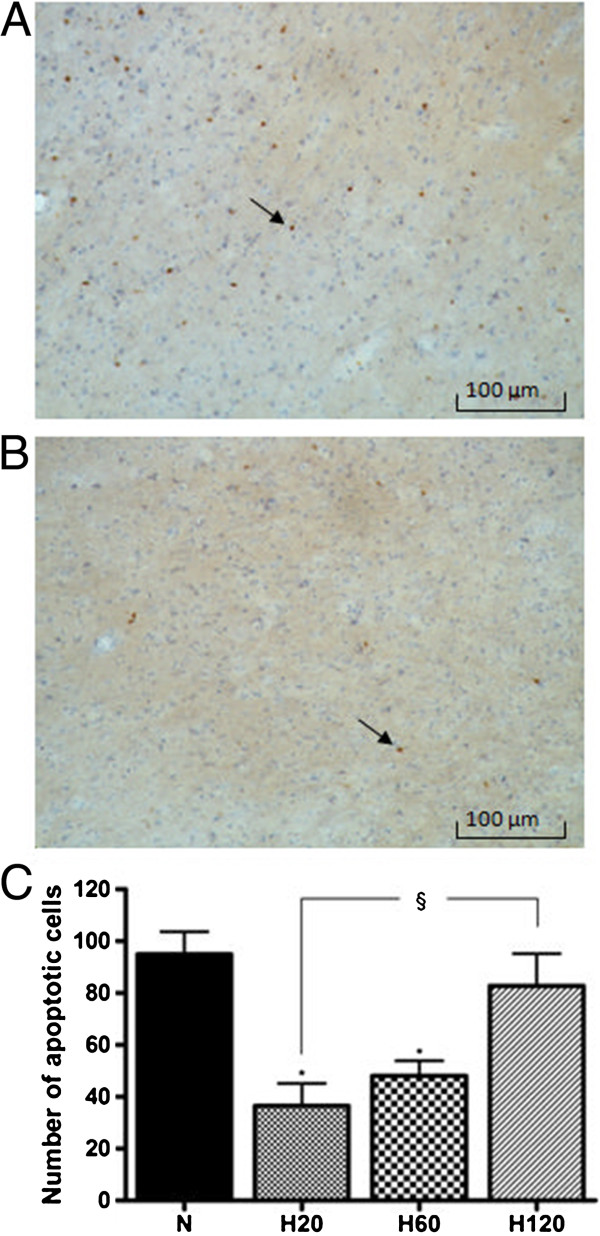
Effect of hypothermic treatments on the Et-1 induced changes in active caspase-3+-cells in the cortex. (A) shows the active caspase-3+-cells of a normothermic rat, while (B) in a hypothermic animal. Graph (C) shows the overall expression of active caspase-3+-cells of the N group (n = 12) and the H20, H60 and H120 group, (n = 7 in each group), in the ischemic hemisphere. There was no staining in the S and the S + H group (n = 7 and 4 respectively, data not shown), and in the contralateral hemisphere of the other groups. Delaying hypothermia up to 60 minutes after the administration of Et-1, reduced the Et-1 induced apoptosis significantly. There was no binding of the second antibody in the absence of the primary antibody (data not shown). *Significantly different compared to the N group. §Significantly different (p < 0.05) from each other.